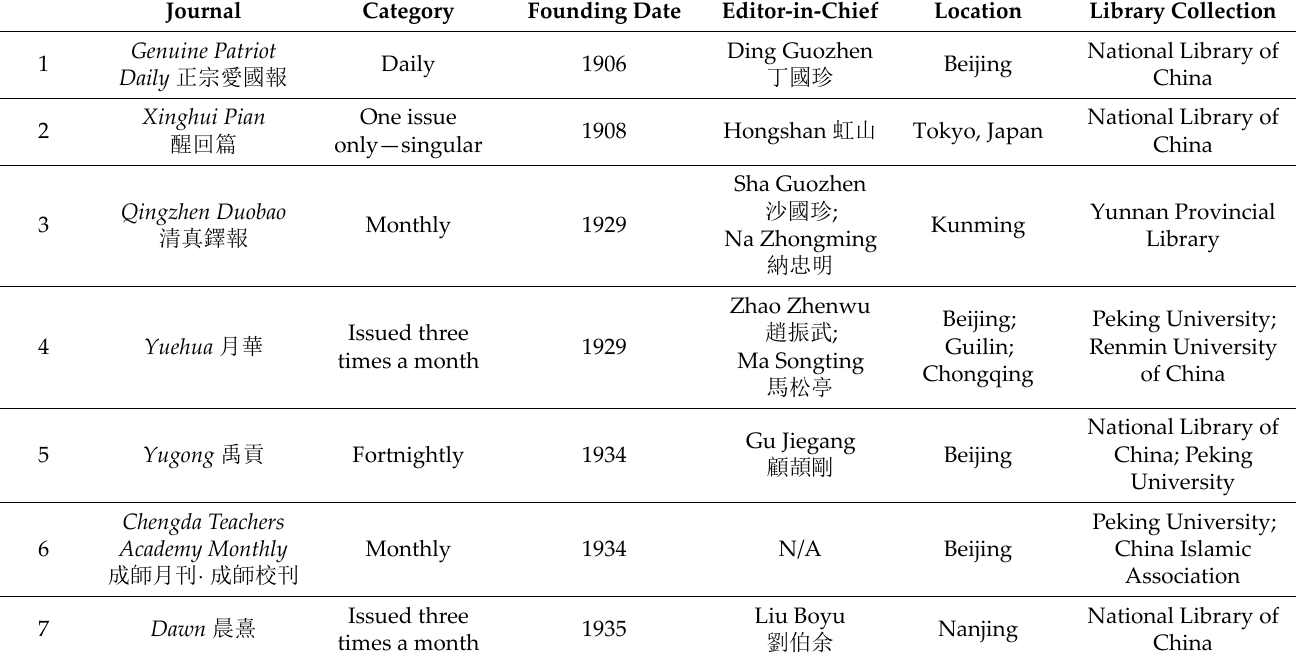
Table 1. Muslim journals cited in this